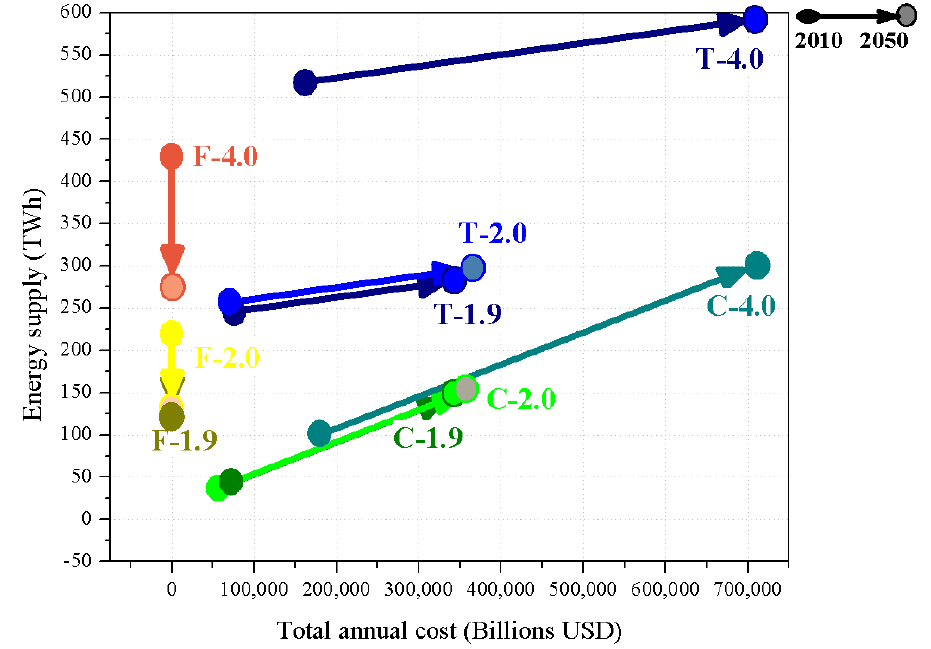
Figure 7. Scheme of the optimized power plants generation centrals number minimizing Total Annual Cost (TAC) of electricity generation for Low Variability of Fertility (LVF) population model [19] and